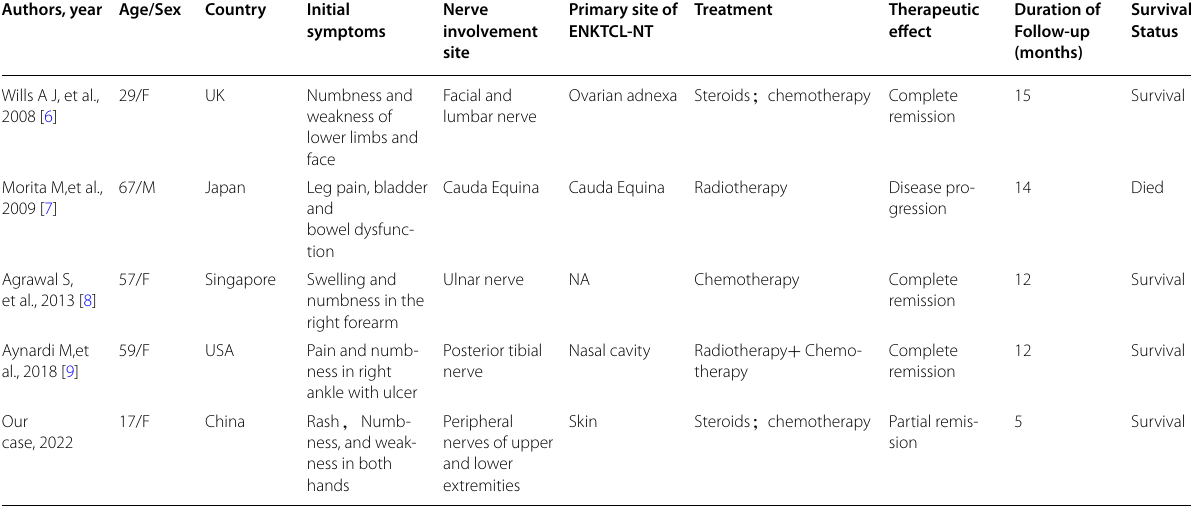
NA Data not available